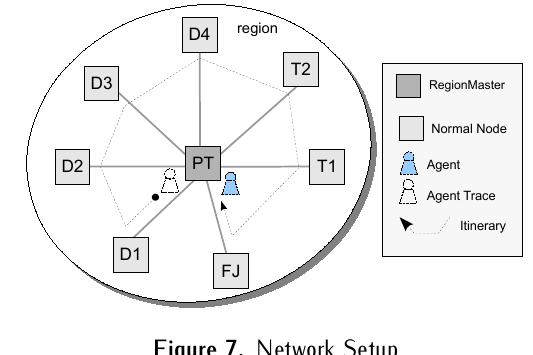
Figure 7. Network Setup